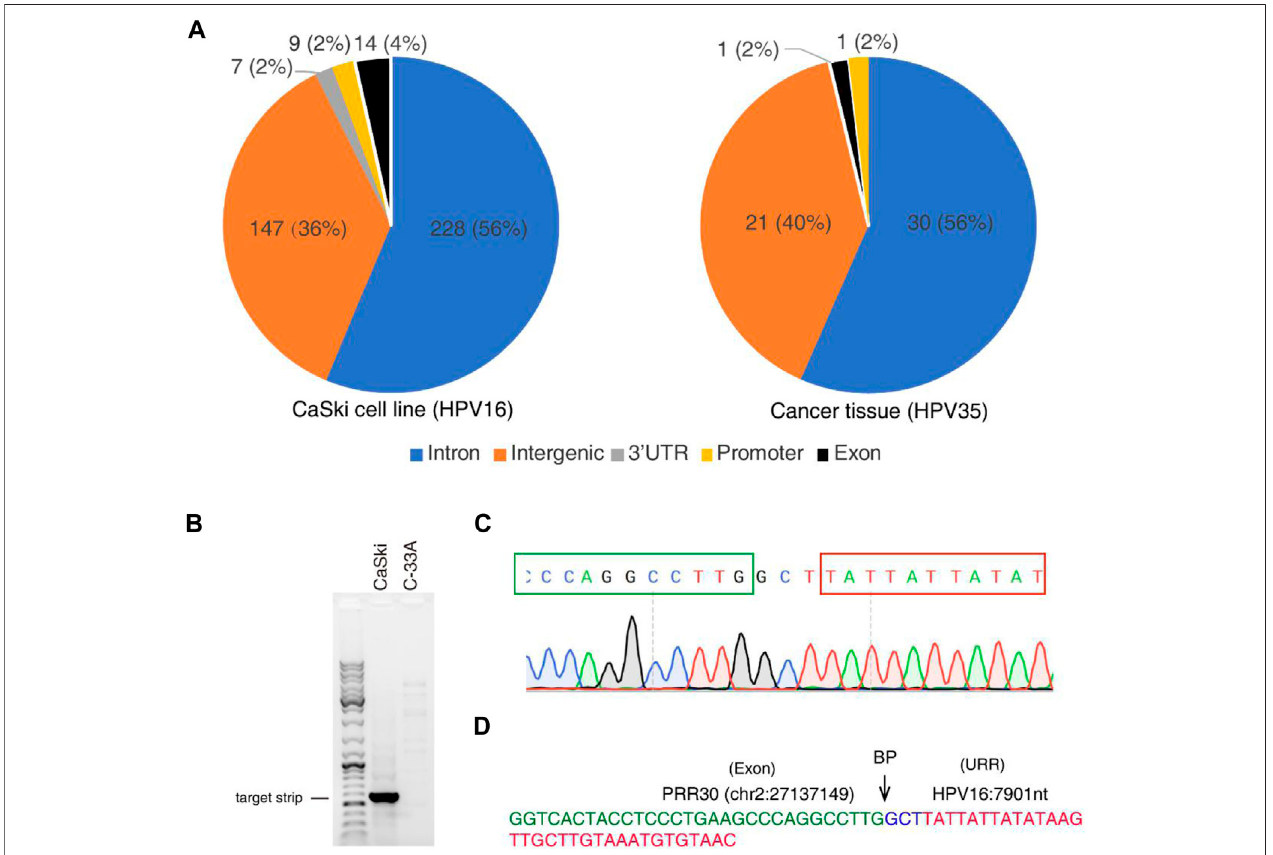
FIGURE 5 | HPV integration sites identi fi ed by nanopore sequencing in CaSki cells and a cervical cancer tissue. (A) Distribution of HPV integration sites in different function regions of human genes identi fi ed from CaSki cells (HPV16) and a cervical cancer tissue (HPV35) by nanopore sequencing. (B) The HPV integration site was ampli fi ed by PCR from the CaSki cells, followed by agarose gel electrophoresis. C-33A cells (HPV-negative cervical cancer cells) was used as a negative control. (C) Sanger sequencing of the HPV integration site. PCR products were subjected to Sanger sequencing. Peaks of nucleotides at integration sites were shown. The cellularsequencefromPRR30wasboxedwithgreencolor,andviralsequencewasboxedwithredcolor. (D) ThesequenceoftheintegrationsitelocatedinPRR30gene. The exon region of PRR30 gene was labeled with green color, and the URR region of HPV genome was labeled with red color. Three random nucleotides at the breakpoint (BP) were labeled with blue